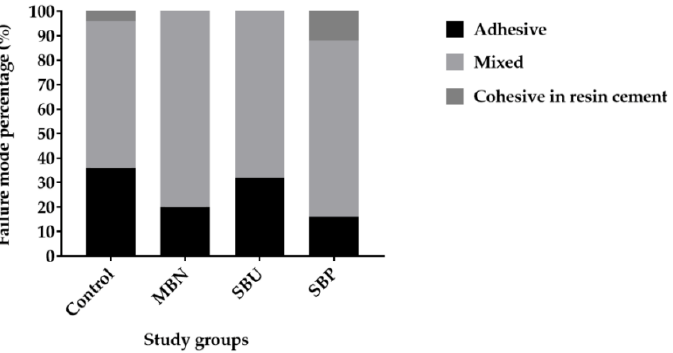
Figure 3. F requencies of failure modes (expressed as percentages) recorded for tested μTBS mi- Figure 3. Frequencies of failure modes (expressed as percentages) recorded for tested µ TBS mi-